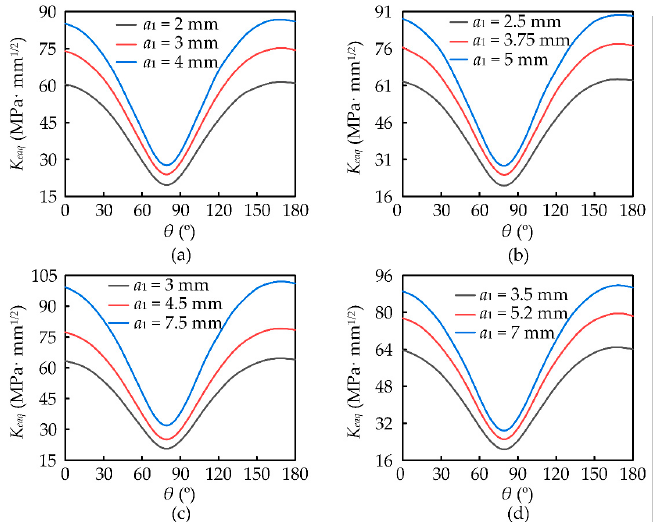
Figure 5. Equivalent SIF for different position angles and parameters in the fore-end of the crack: ( a ) a 1 / c 1 = 0.5, ( b ) a 1 / c 1 = 0.625, ( c ) a 1 / c 1 = 0.75, and ( d ) a 1 / c 1 = 0.875. The results (Figure 5) clearly show that with the change of the crack position angle, the equivalent SIF in the fore-end of the crack also changed, and the closer the position angle is to 80°, the smaller the equivalent SIF was, which indicated that the crack growth trend was relatively weak. When the crack position angle was closer to 0°, the equivalent